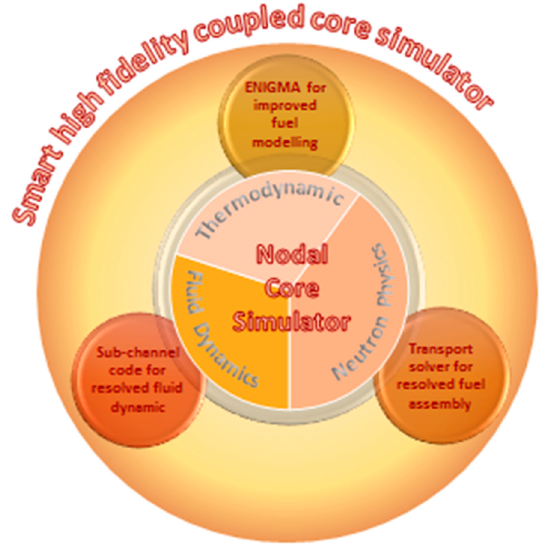
Figure 3. The scheme for the smart high-fidelity coupled core simulator to replace the pin-power reconstruction for determining the safety limits of the fuel using a hybrid approach and improved physical coupling.